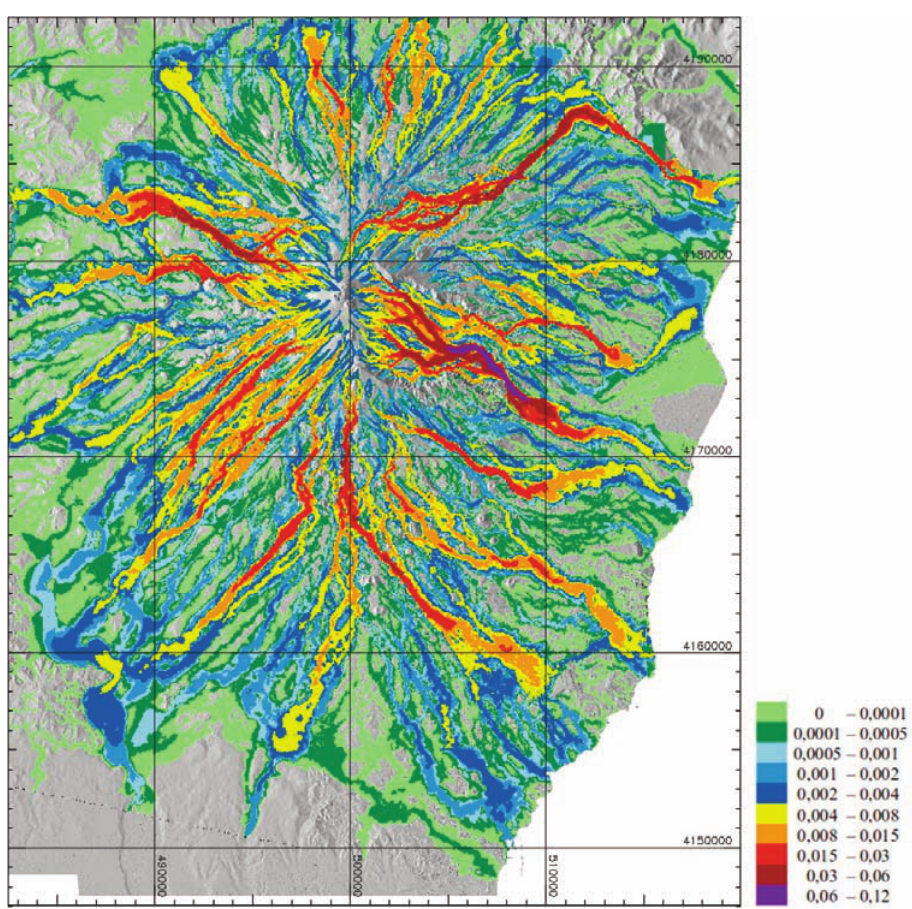
Figure 2. Lava-flow hazard map at Mount Etna, constructed using the learning dataset (reference time 1981). The colors represent different levels of lava- flow invasion hazards.